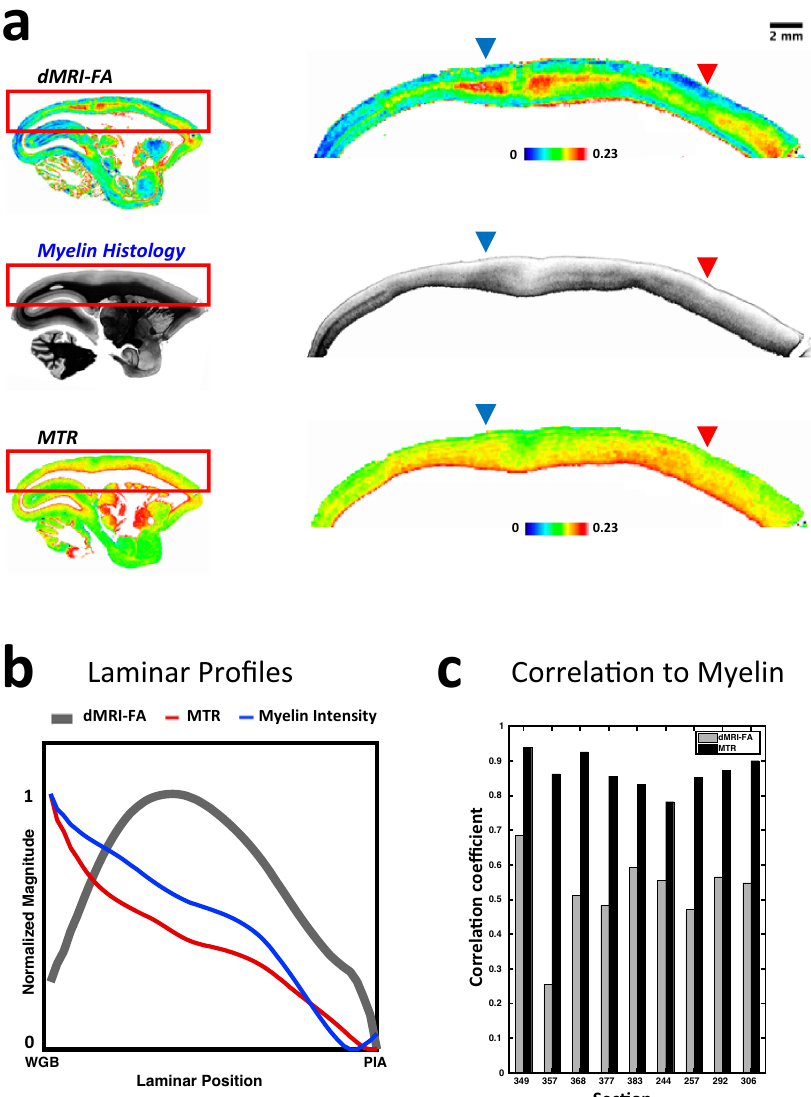
Fig. 1 | Comparison of dMRI-FA to corresponding myelin histology and MTR MRI data obtained from the same tissue in the right hemisphere of marmoset monkey case P. a Sagittal sections of dMRI-FA (top), Myelin histology (center), and MTR MRI (bottom). The spatial variation of dMRI-FA in vertical (laminar) and horizontal direction showed minimal correspondence with the pattern of myelin intensity, but the variation of the MTR MRI closely mirrored the myelin variation. In some regions of high myelination (dark colour in histology), the dMRI-FA was high (red arrow) whereas in others it was low (blue arrow). b Normalized average